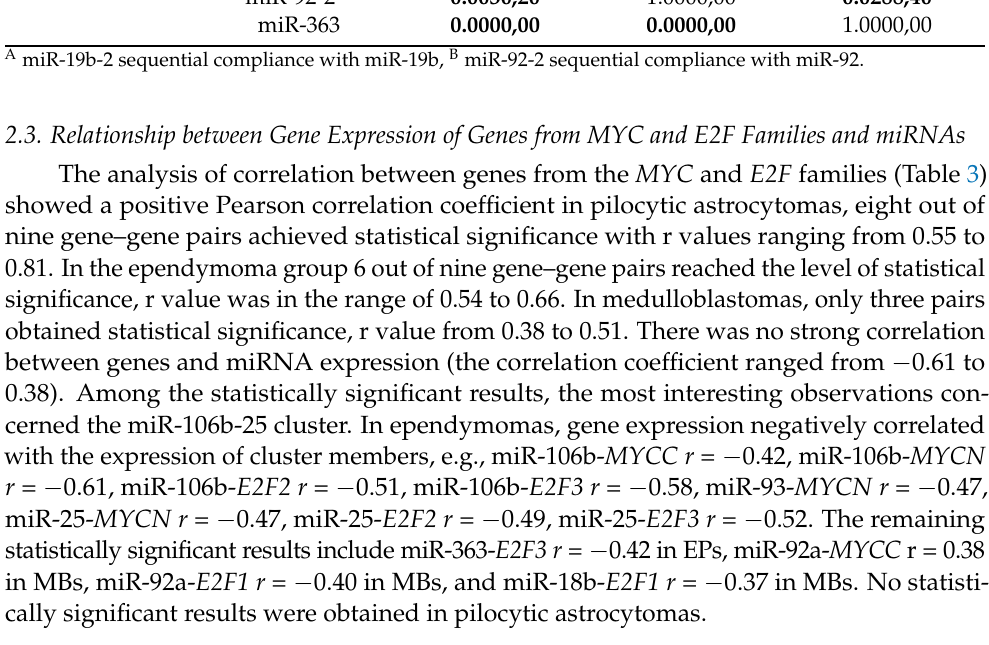
Table 3. Pearson correlation coefficients between members of the MYC and E2F families in three analyzed groups. If p value is less than 0.05 we report the result as statistically significant (indicated in bold). MB, medulloblastoma; EP, ependymoma; PA, pilocytic astrocytoma. Gene–Gene MB EP PA MYCC-E2F1 −